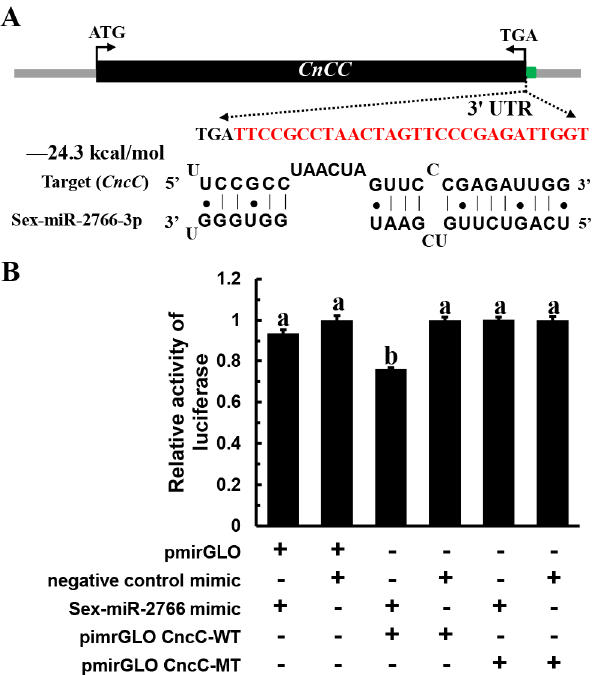
Figure 2. Verification of the interaction between Sex-miR2766 and SeCncC using a dual fluorescent reporter system. ( A ) Predicted target site (red bases) of Sex-miR-2766-3p in the 3′ UTR of SeCncC . ( B ) Luciferase reporter assays were performed to validate the interaction of Sex-miR-2766-3p with SeCncC in vitro. The mutated nucleotides are shown in italics. Data are presented as the means ± standard errors. The data were analyzed using analysis of variance followed by Tukey’s multiple comparisons, and the treatments designated with different letters were significantly different from each other at p < 0.05.